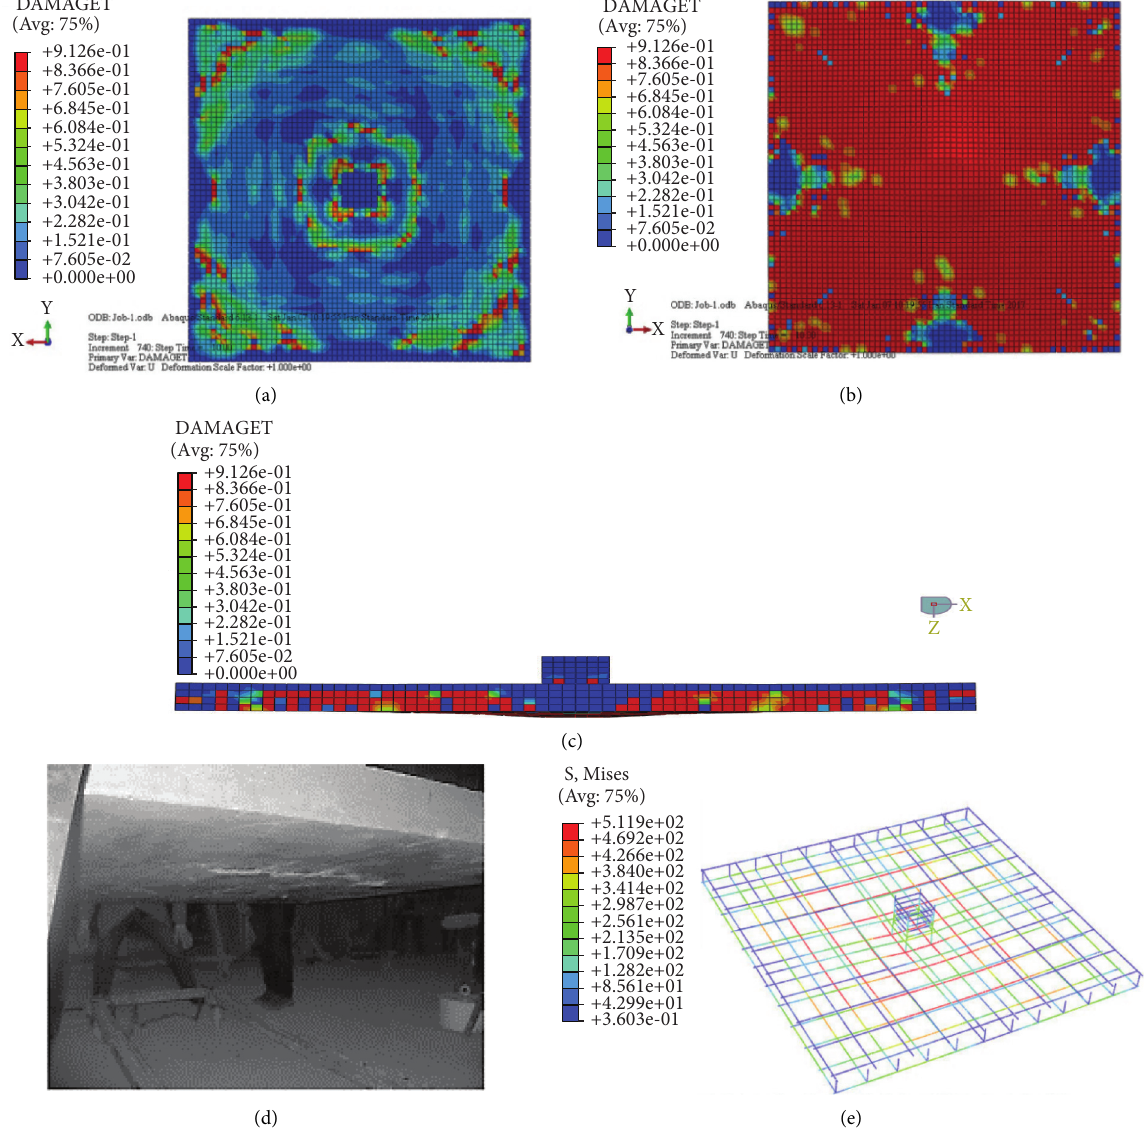
Figure 7: Numerical model validation results. (a) Cracks on the top of the concrete slab. (b) Cracks on the bottom of the concrete slab. (c) Side view of cracked concrete slab. (d) Concrete slab cracking at laboratory model. (e) Stress distribution in slab